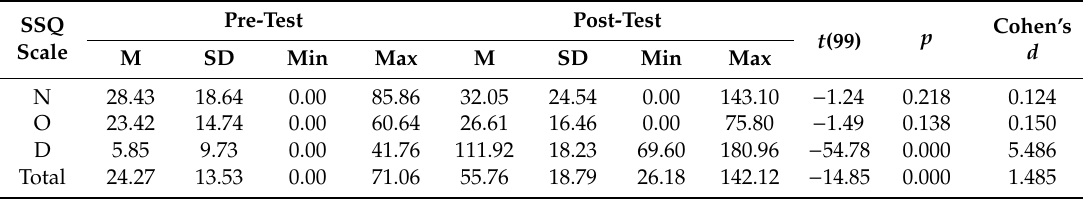
Table 2. Descriptive statistics of each scale of the Simulator Sickness Questionnaire (SSQ) for pre- and post-test (the paired sample t -test).